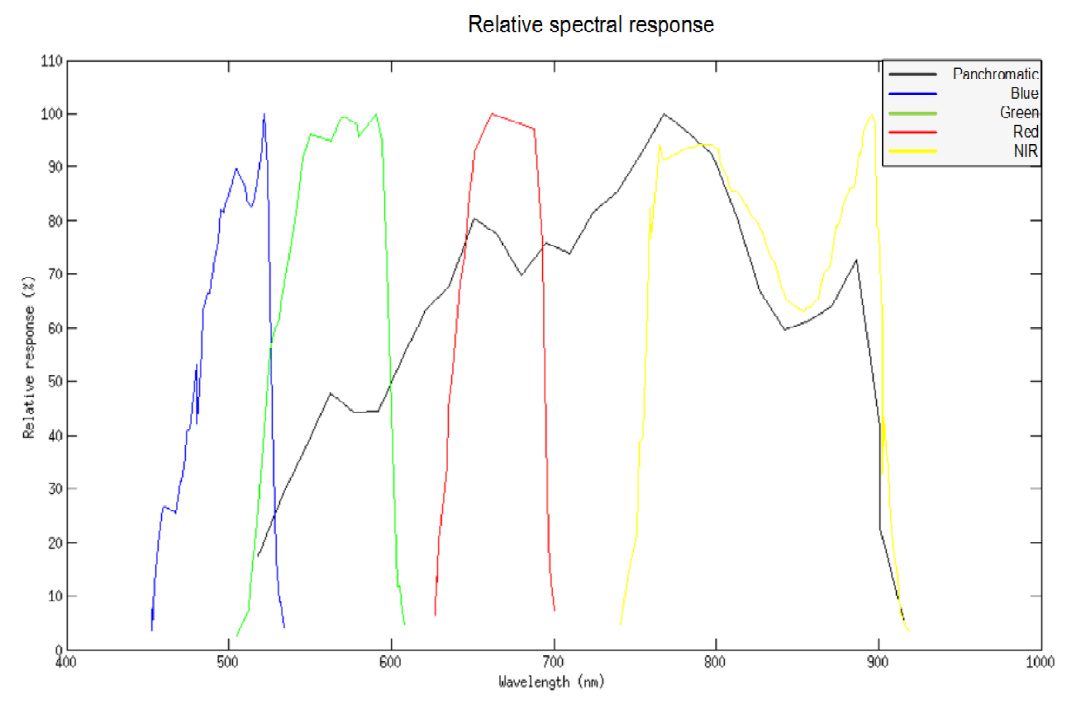
Figure 2. Relative spectral response: panchromatic images (0.50–0.90 µ m), blue band (0.45–0.52 µ m), green band (0.52–0.60 µ m), red band (0.63–0.69 µ m), and NIR band (0.76–0.90 µ m).